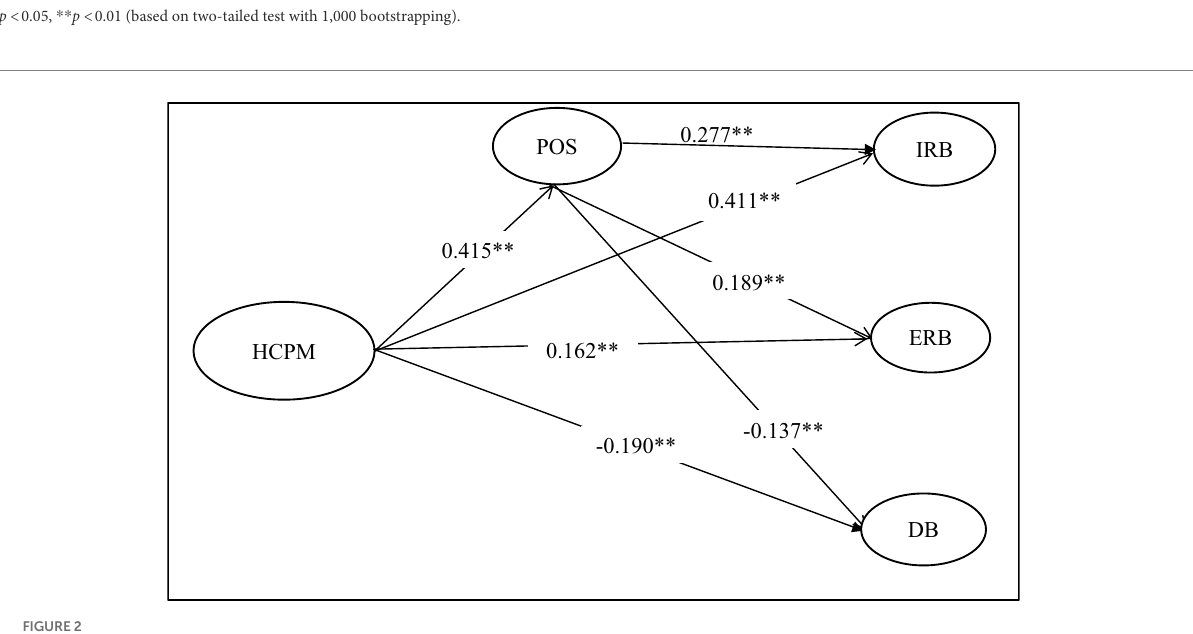
FIGURE 2 Structural